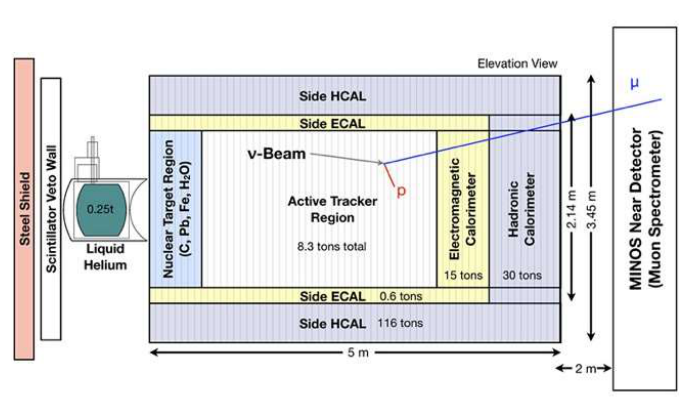
Figure 5. MINERvA Neutrino detector at